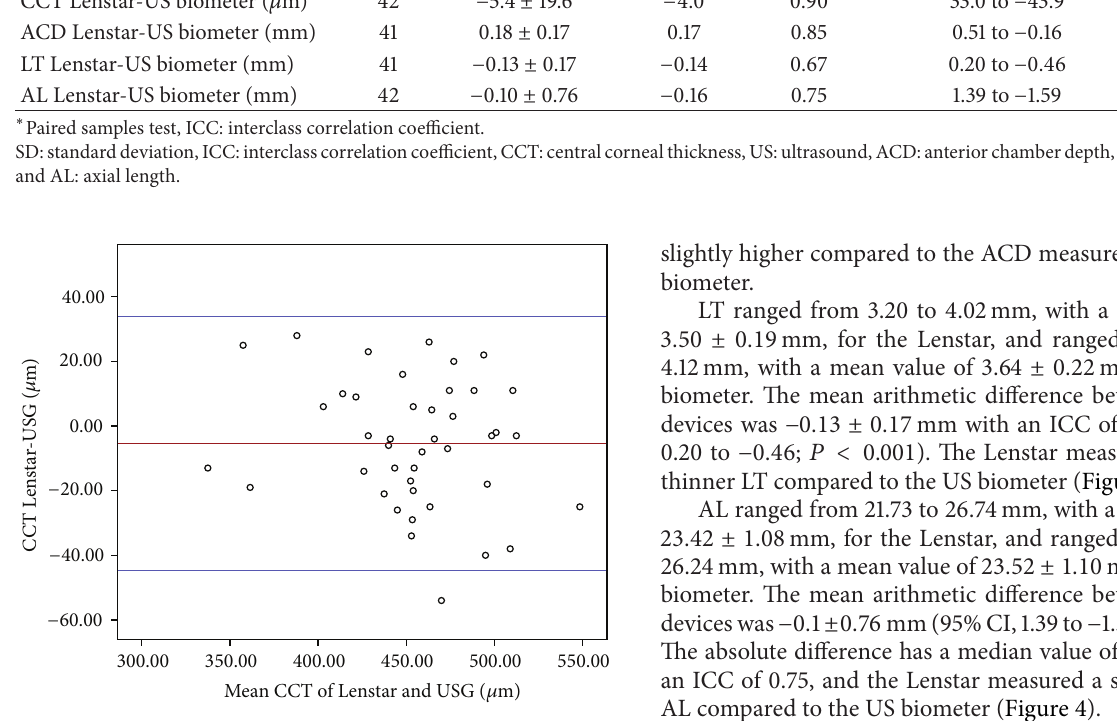
Figure 1: The Bland-Altman plot (left) showing differences in average corneal thickness (CCT) measurement of the devices. The bold horizontal line demonstrates the mean difference between the devices. The dotted lines above and below represent the 95% limits of agreement